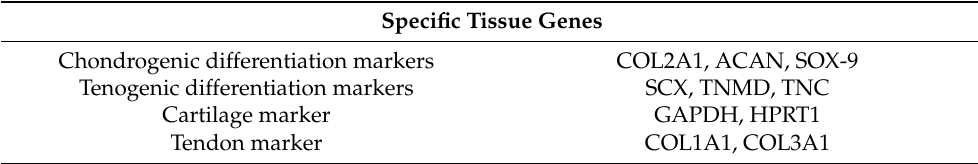
Table 1. Specific tissue genes to evaluate for tendon regeneration.